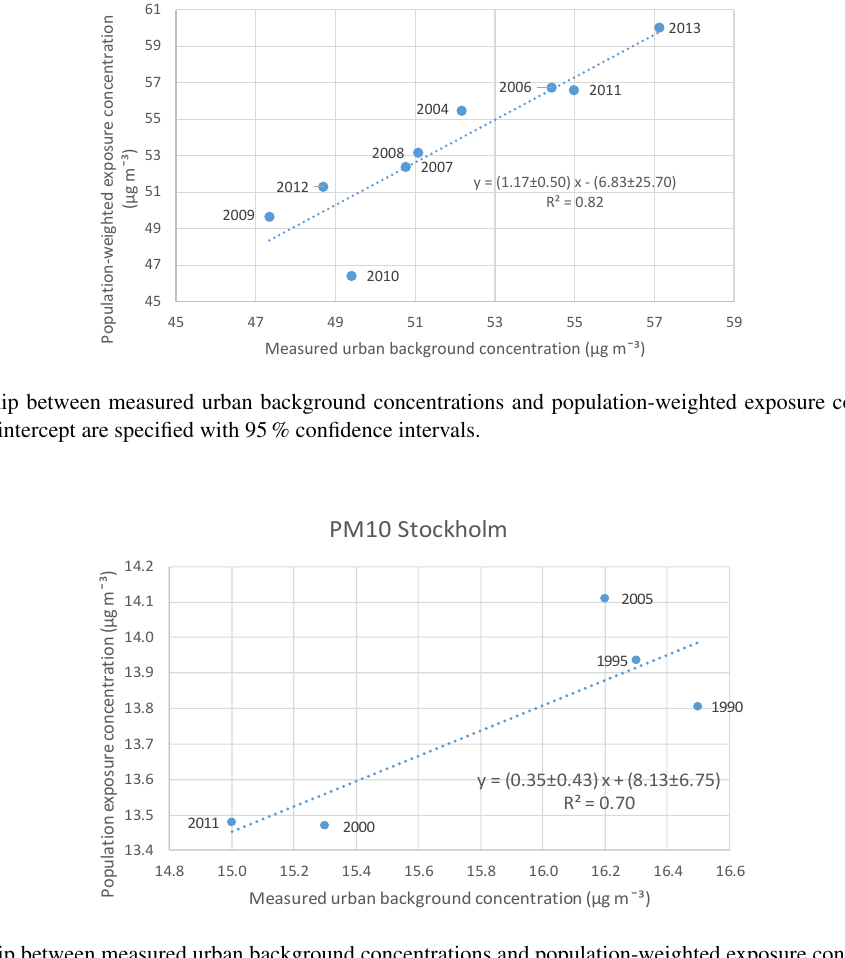
Figure A4. Relationship between measured urban background concentrations and population-weighted exposure concentrations of PM 10 in Stockholm. Slope and intercept are specified with 95% confidence